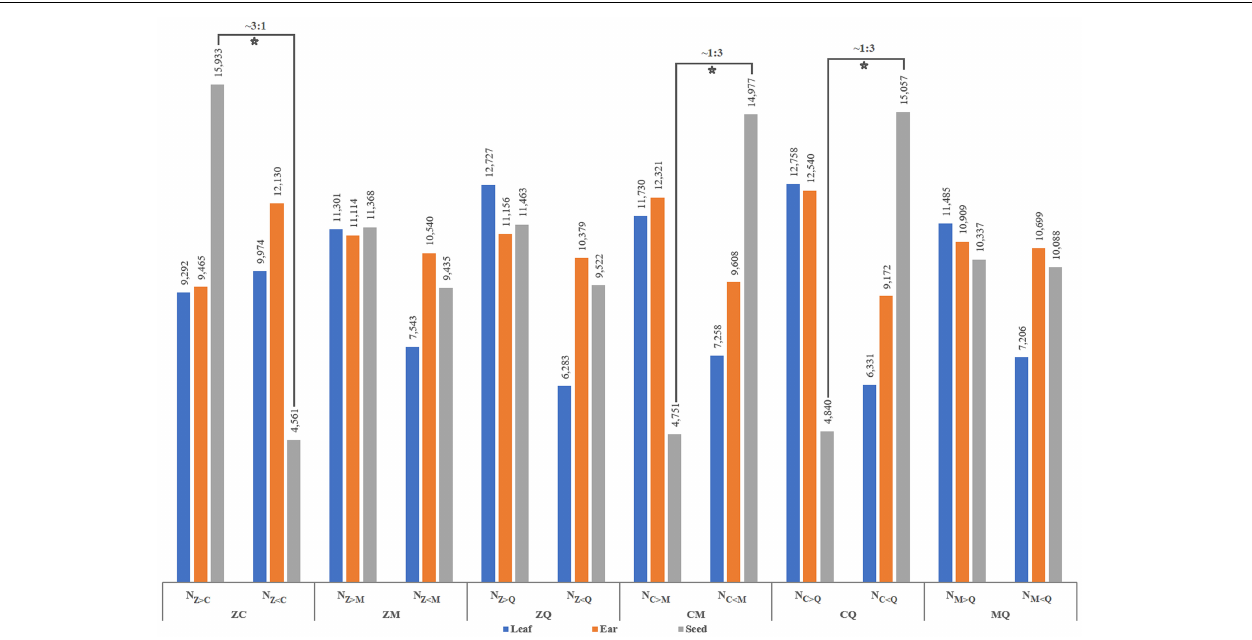
FIGURE 1 | Variation in the number of DEGs between parental inbred lines. Nz > c denotes the number of genes whose value of FPKM is greater in parent Zheng58 than in parent Chang7-2, and the same goes for other acronyms. The numbers at the top of the bar chart represent the number of different types of DEGs, the hollow five-pointed stars show special proportions of the number of genes, and the tissues [leaves (L), ears (E), and seeds (S)] shown in different colors are listed on